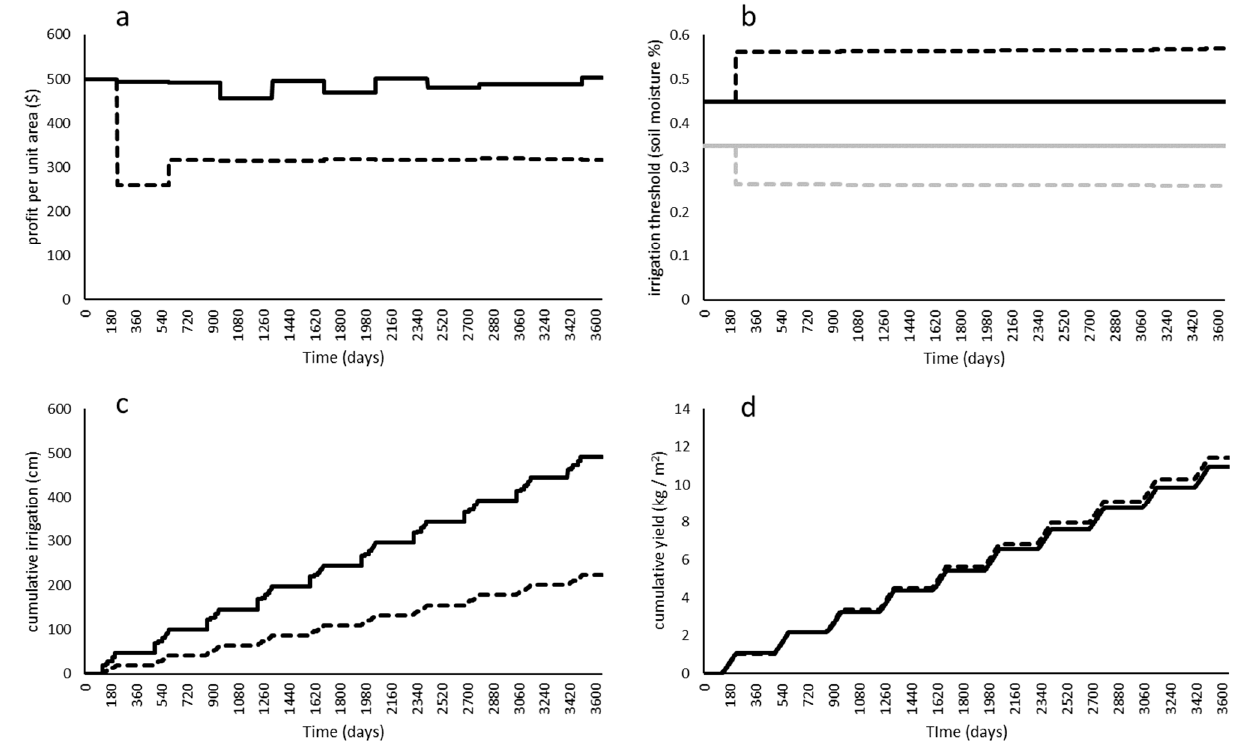
Figure 7. Economic and agronomic results from the irrigation test switch from flood to drip irrigation over 10 years (3650 days): (panel a ) crop profit per unit area ($) illustrating long-run equilibrium for the base case (solid line) and a long-run positive yet reduced profit rate under the drip method (dashed line); (panel b ) target (black lines) and threshold (gray lines) soil moisture levels used to manipulate irrigation applications, which are static in the base case (solid) but altered in the drip case (dashed) given the use of the heuristic, effectively increasing irrigation depth per application via reduced threshold and higher target moisture levels; (panel c ) cumulative irrigation over 10 years under flood (solid line) and drip irrigation (dashed line) methods; and (panel d ) cumulative yield over 10 years under flood (solid line) and drip irrigation (dashed line) methods.